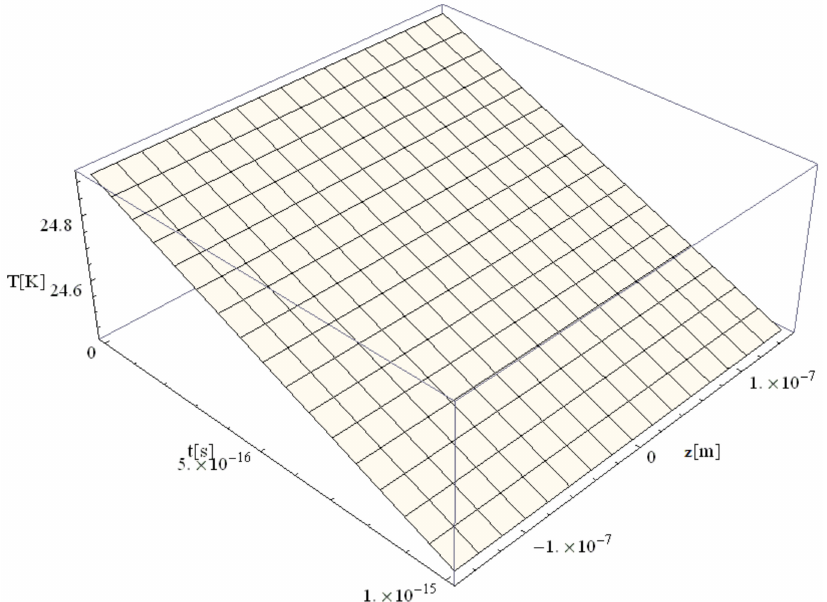
Figure 6. Electron temperature versus time and z during 1 fs simulation after irradiation with a 100 as laser pulse applied to an Au microparticle with a 150 nm radius.